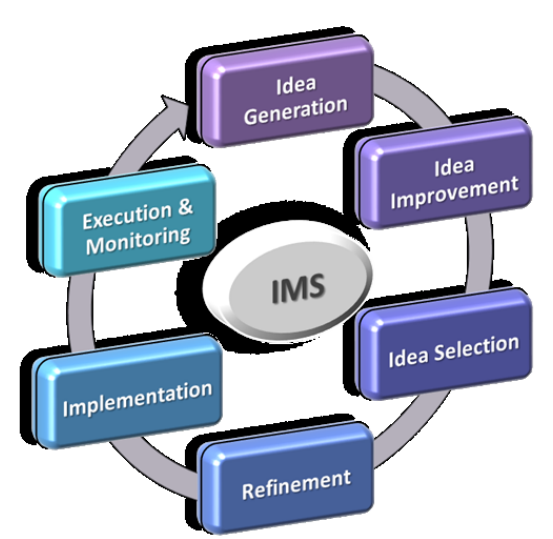
Figure 1. Main steps of idea